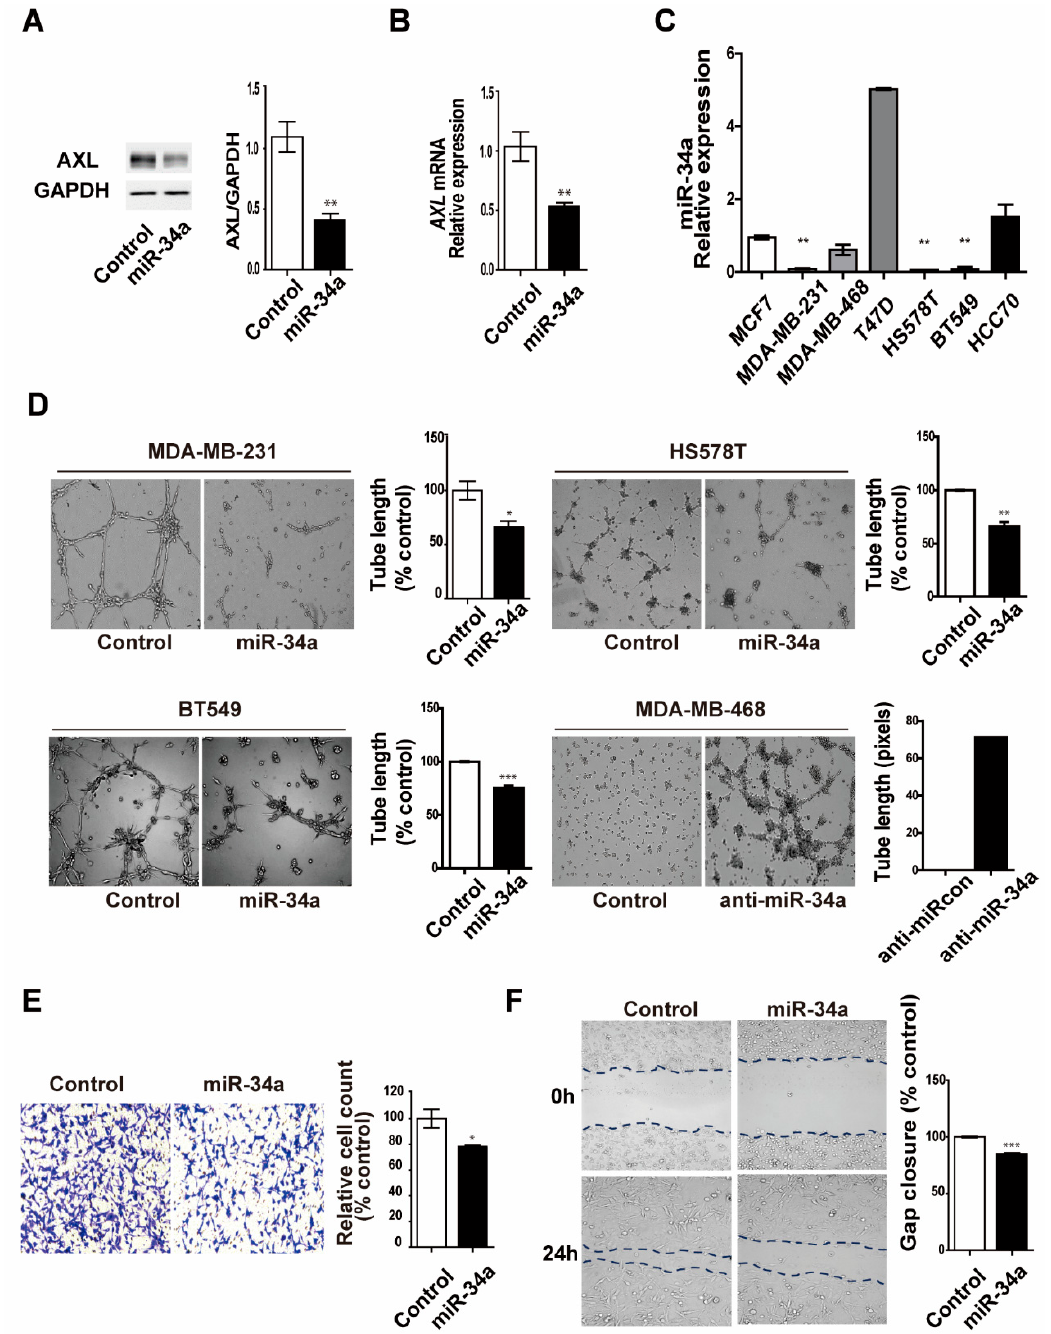
Figure 5. AXL-targeting miR-34a regulates cell invasion, migration, and vasculogenic mimicry formation in MDA-MB-231 breast cancer cells. ( A ) AXL protein and ( B ) mRNA expression in response to overexpression of miR-34a mimics or inhibition of miR-34a with anti-miRs in MDA-MB-231 breast cancer cells. ( C ) miR-34a expression in breast cancer cell lines. ( D ) VM formation ability in response to overexpression of miR-34a or inhibition of miR-34a with anti-miRs in MDA-MB-231 and MDA-MB-468 breast cancer cells, respectively. ( E ) Invasion and ( F ) migration by overexpression of miR-34a mimics in MDA-MB-231 breast cancer cells. * p < 0.05, ** p < 0.01, *** p < 0.001 versus controls, calculated using unpaired two-tailed Student’s t -test. Error bars, S.E.M.